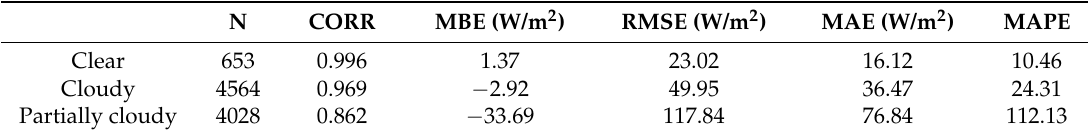
Table 3. Results of statistical assessment for the SSI_VIS product with respect to SSI_Ground. Units of the statistical scores are specified in the bracket. N indicates the number of used pixels.